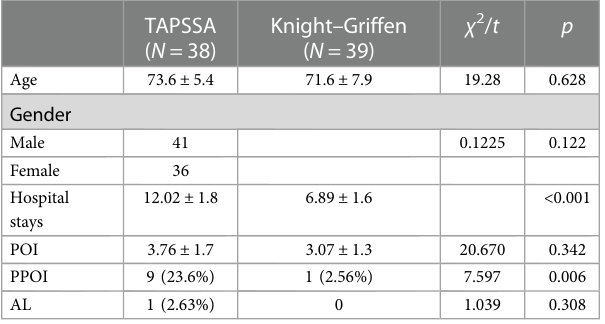
TABLE 1 Analysis and comparison between the two